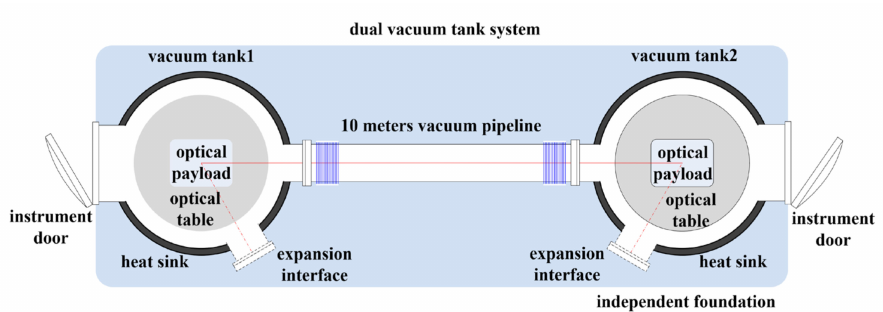
Figure 12. Simulation of the space environment for the two spacecrafts using the dual vacuum tank system (top